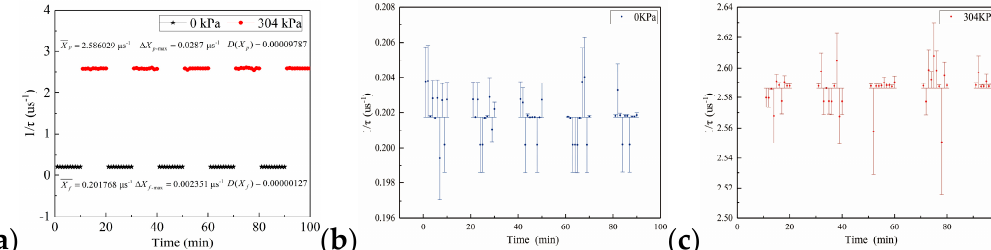
Figure 10. Repeatability test results of pressure sensor on the sidewall; ( a ) the ring-down time curve when 304 kPa is loaded and not loaded on the sensor; ( b ) the error bar of 1 / τ response when 304 kPa